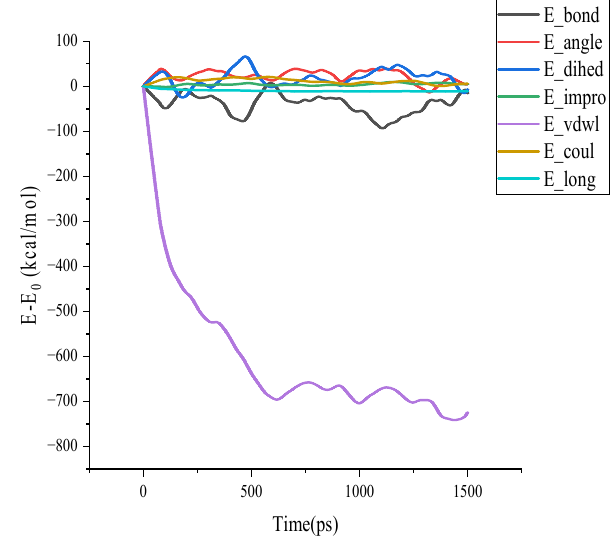
Figure 15. Energy change diagram of self-healing process.